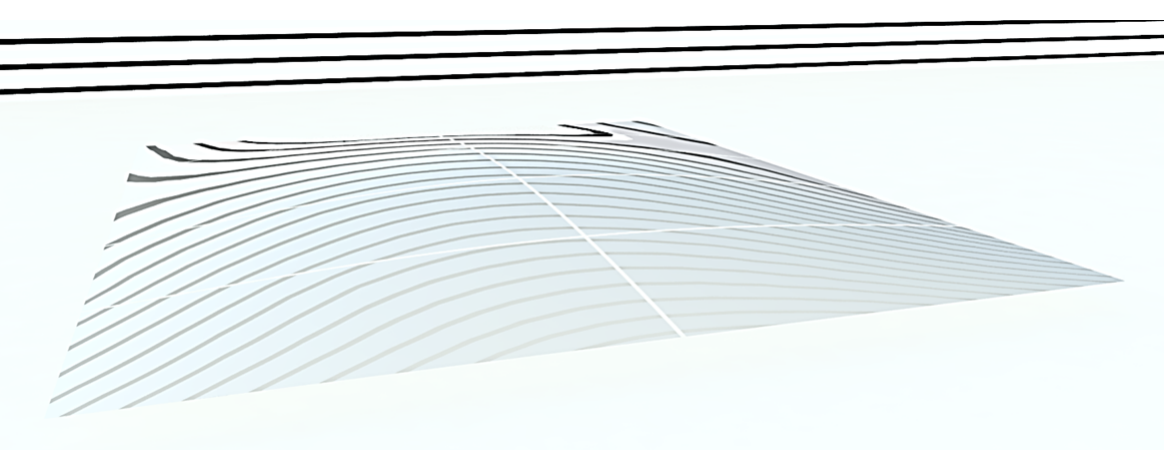
Fig. 5 Surface continuity of multiple sheet